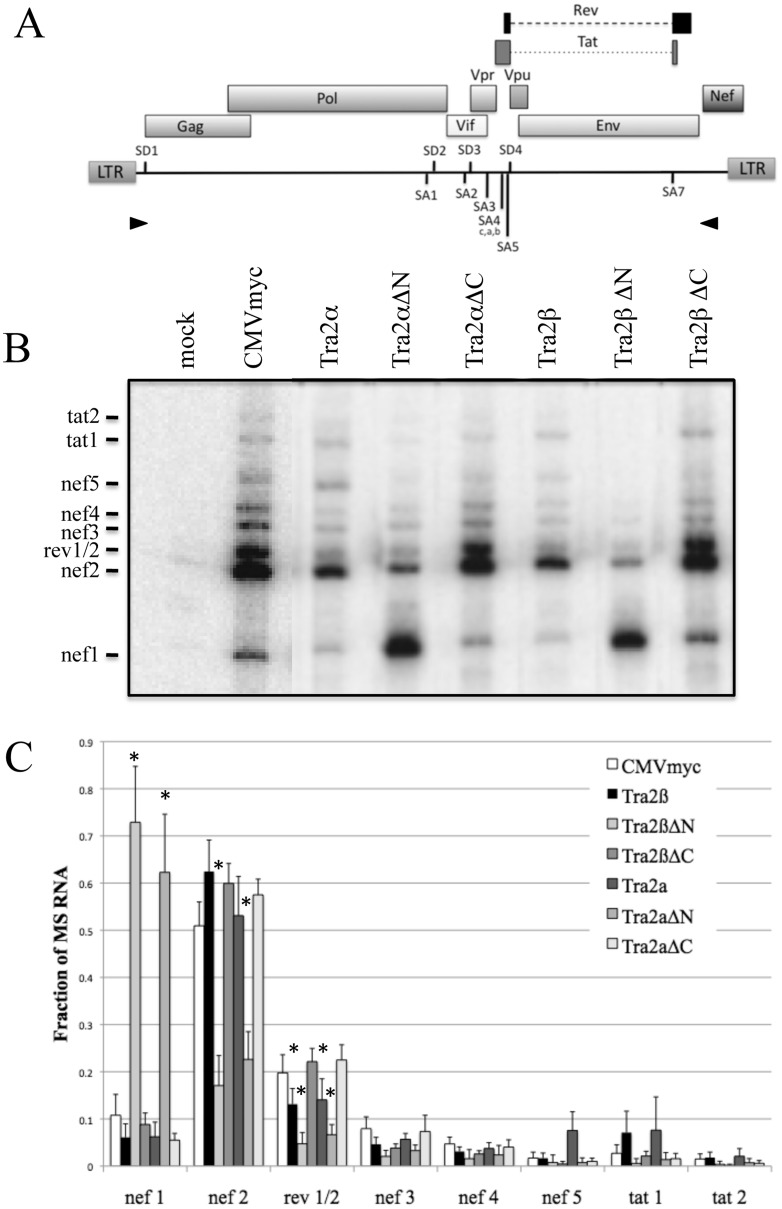
Tra2α/β Overexpression Alters HIV-1 Splice Site Usage.A, Schematic of the HIV-1 provirus, indicating the position of the primers (arrowheads) used for the RT-PCR analysis of HIV-1 MS RNA. B, 293T cells were transfected with pHxb2 R-/RI- with the indicated myc-expression vectors. RNA was extracted, cDNA generated and amplification of HIV-1 MS RNA performed as outlined in “Materials & Methods”. Shown is a representative gel of the results obtained. The products generated are identified on the left. See Fig A in S1 File for a description of the products generated. Products generated from untransfected cells (mock) are also shown. C, Summary of results from n.>3 assays. Values are the relative fraction of total signal for each of the amplicons generated. Asterisks indicated values deemed significant from control (CMVmyc) at p<0.05.